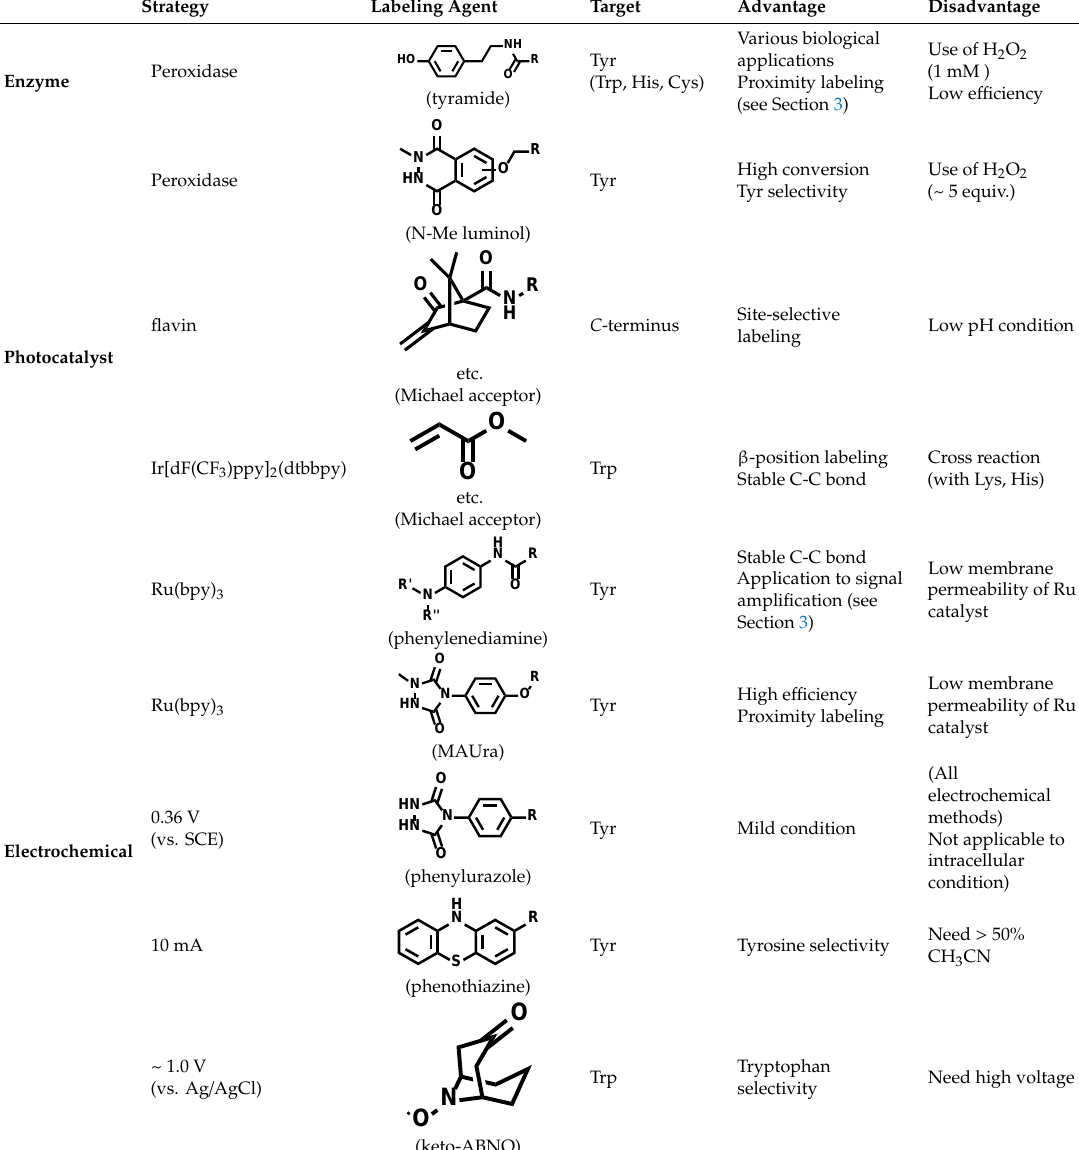
Table 1. Overview of protein labeling methods using biomimetic radical reactions.